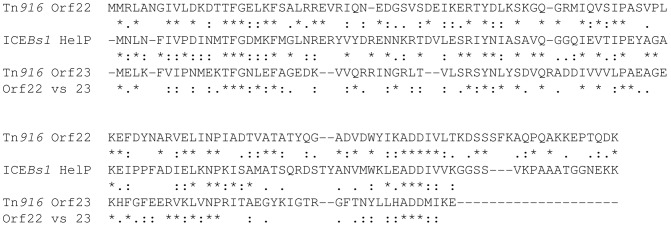
Comparison of HelP to Orf22 and Orf23 of Tn916.HelP (middle sequence), Orf22 of Tn916 (top sequence) and Orf23 of Tn916 (bottom sequence) were aligned using Clustal X. Markings above and below the HelP sequence indicate which amino acids are identical (asterisk), highly similar (colon) or weakly similar (period) to Tn916 Orf22 (marks above) and Tn916 Orf23 (marks below). Markings for the pairwise comparison of Orf22 to Orf23 are shown below the Tn916 Orf23 sequence. Needleman-Wunsch alignment scores indicate that HelP is more similar to Orf22 and Orf23 (N-W scores = 142 and 104, respectively) than Orf22 is to Orf23 (N-W score = 31). ICEBs1 HelP is 126 amino acids, Tn916 Orf22 is 128 amino acids, and Tn916 Orf23 is 104 amino acids.